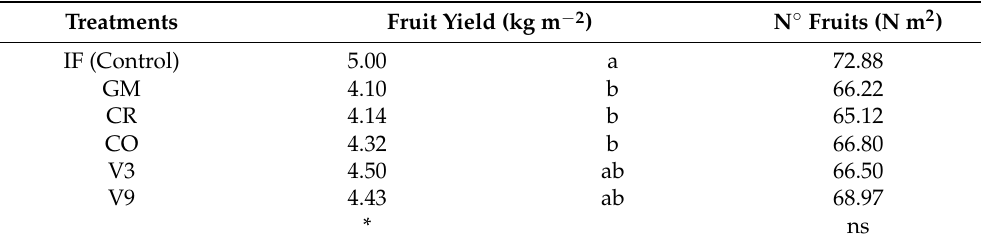
Table 3. Effect on fruit yield (kg m − 2 ) and fruit number (N m − 2 ) in tomato crop fertilised with inorganic fertilisers (IF), goat manure at 3 kg m − 1 (GM), crop residue at 4 kg m − 1 (CR), compost